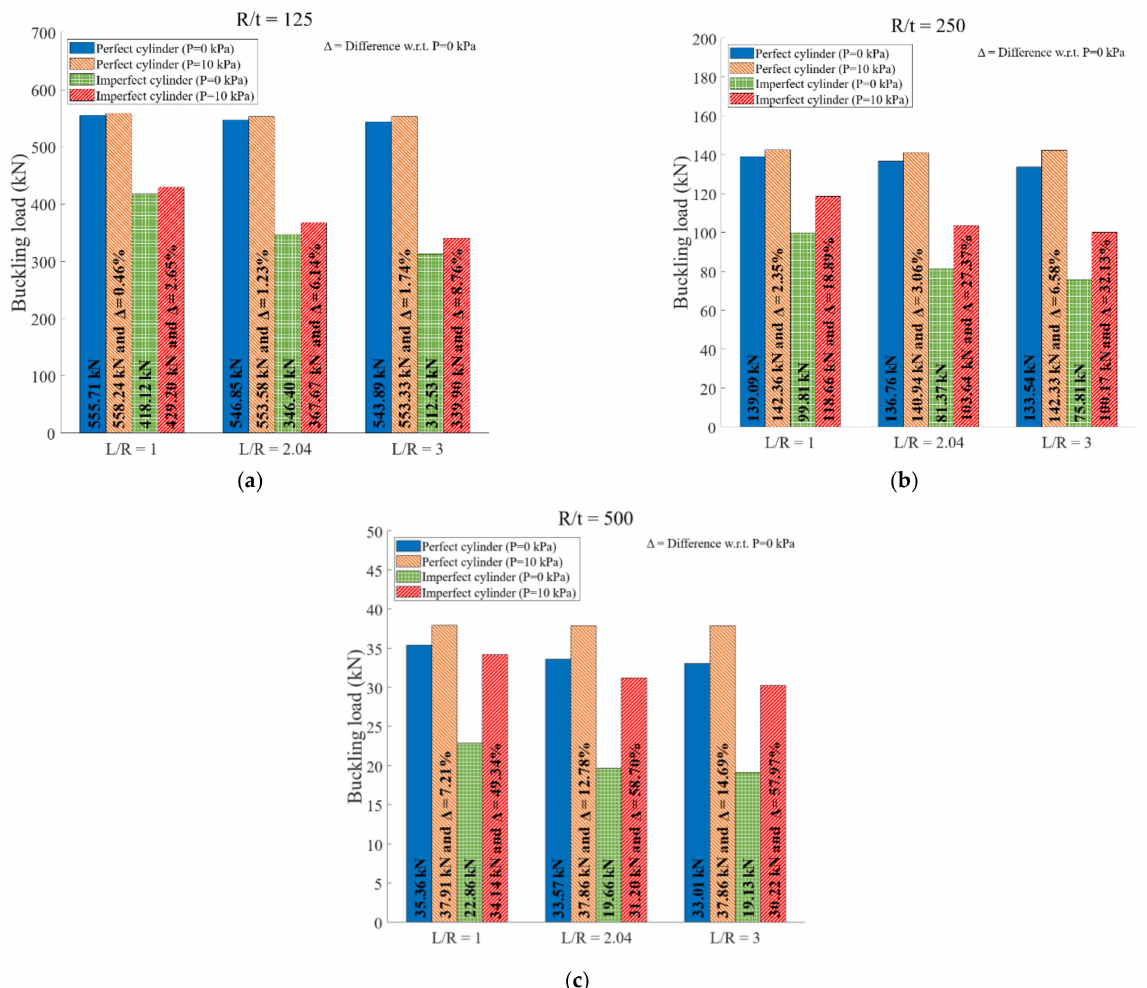
Figure 12. Global buckling loads of the thin-walled composite tank models with and without the internal pressure. ( a ) R / t = 125, ( b ) R / t = 250, ( c ) R / t =